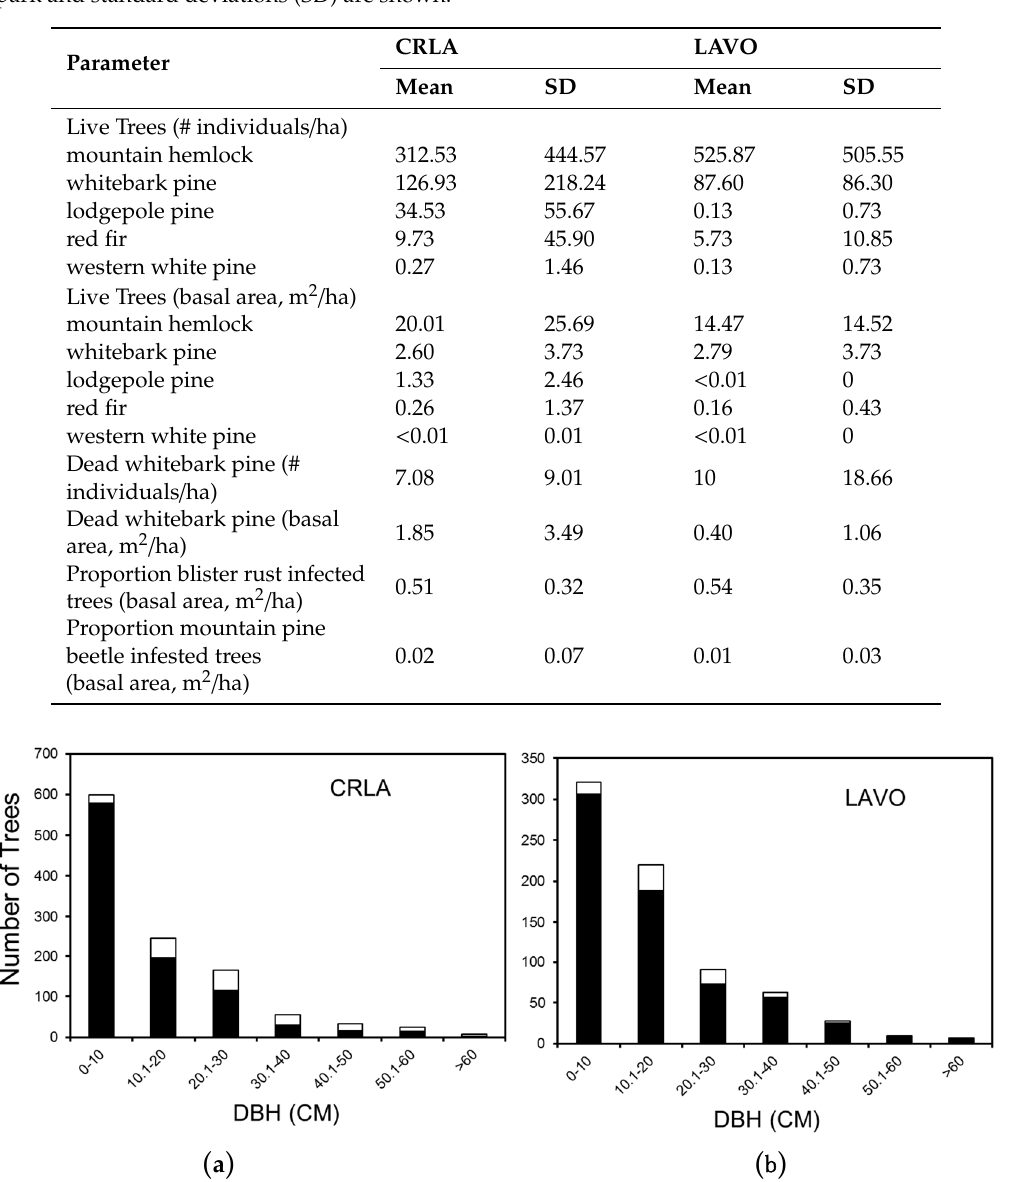
Figure 4. Diameter at breast height distribution of whitebark pine found in 30 plots established in both ( a ) Crater Lake (CRLA) and ( b ) Lassen Volcanic (LAVO) National Parks. Black fill represents living trees and white fill represents dead trees.